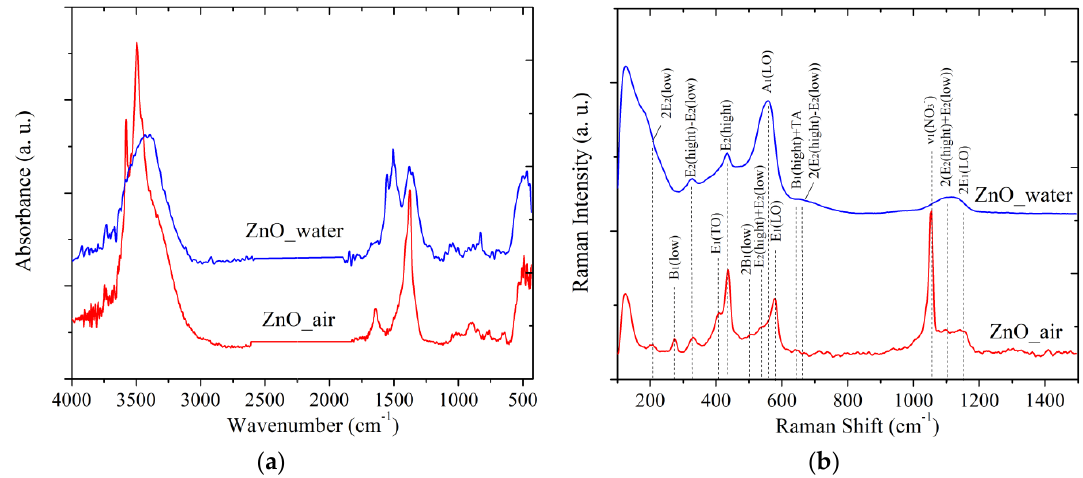
Figure 7. FTIR ( a ) and Raman ( b ) spectra of powder samples. Red and blue lines present data for samples prepared in air and water, respectively.